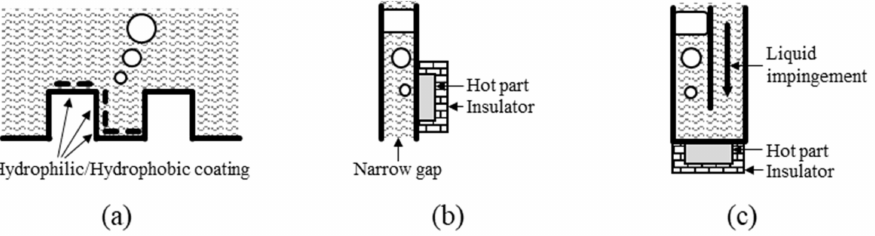
Figure 7. Examples of experimental setting ( a ) Silicon channel with partial surface coating ( b ) Using surface tension ( c ) Vertical guidance tube.